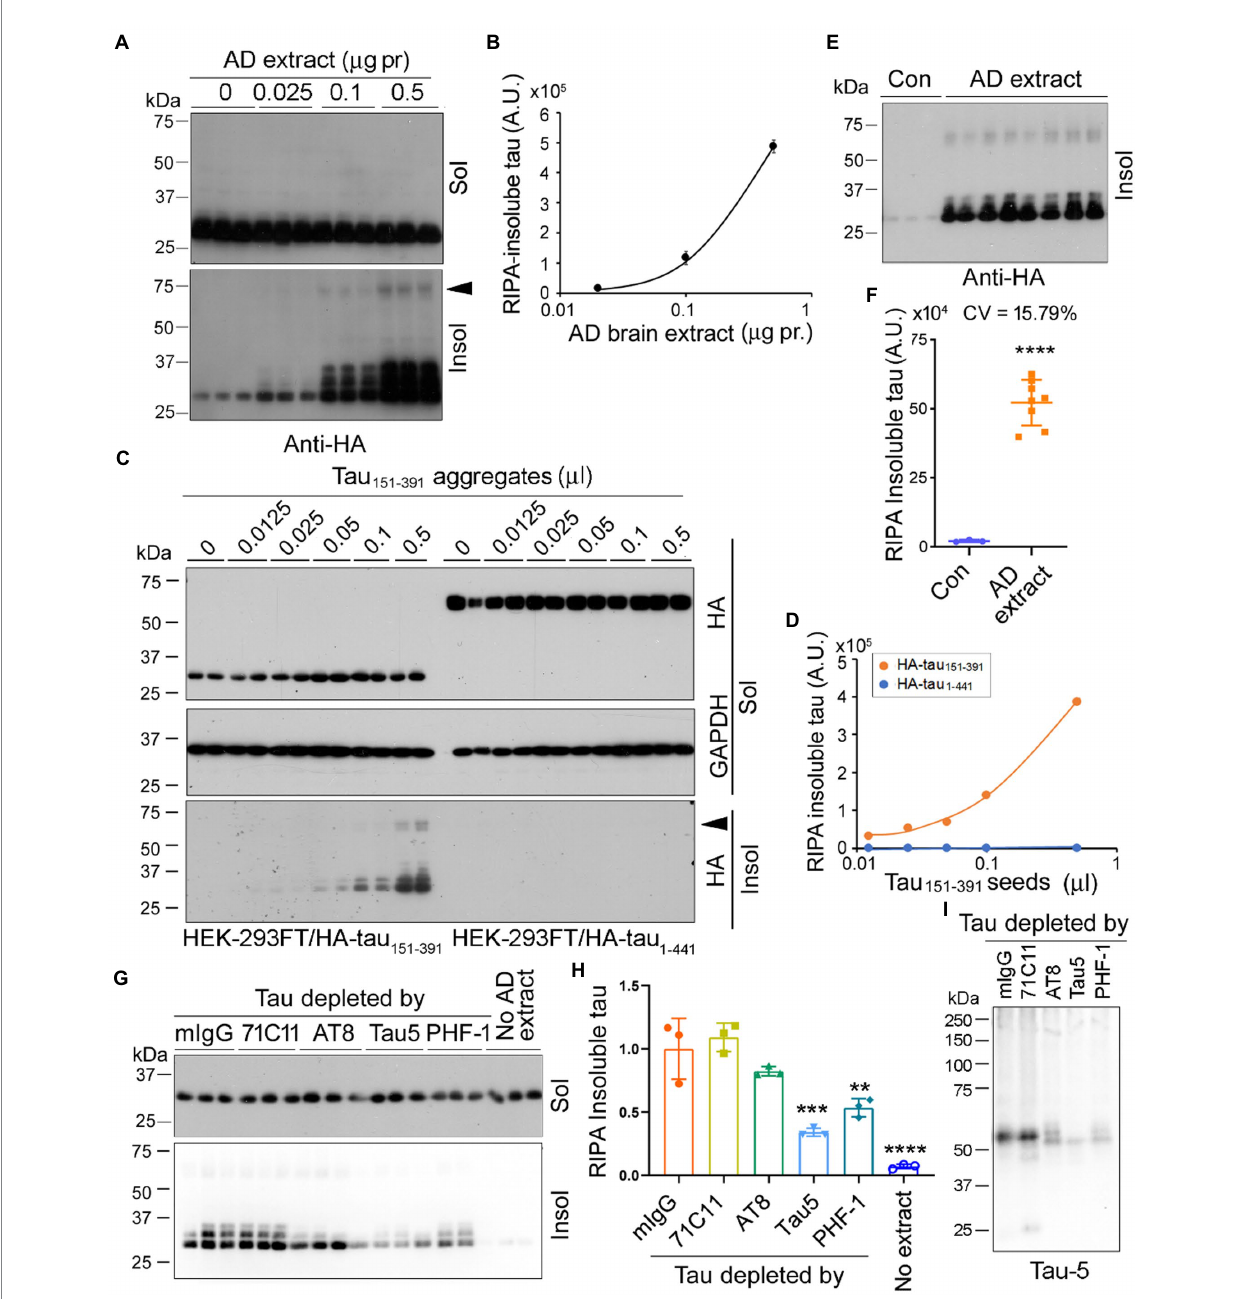
FIGURE 6 Seed-competent tau from AD brain templates tau 151-391 aggregation. (A,B) AD brain extract seeded tau aggregation. HEK-293FT cells expressing HA- tau 151-391 in triplicate were treated with various amounts of AD brain extract for 42 h. The RIPA-soluble and -insoluble taus were analyzed (A) . RIPA- insoluble tau was plotted against the amount of AD brain extracts (B) . (C,D) RIPA-insoluble tau aggregates seeded tau aggregation. HEK-293FT cells expressing HA-tau 151-391 or HA-tau 1-441 in duplicate were treated with various amounts of tau 151-391 aggregates for 42 h. The RIPA-soluble and -insoluble taus were analyzed (C) . RIPA-insoluble tau was plotted against amounts of tau 151-391 aggregates (D) . (E,F) AD brain extract seeded tau aggregation reproducibly. HEK-293FT/HA-tau 151-391 cells were treated with 0.5 μ g protein of AD brain extract in octuplicate. The RIPA-insoluble tau was analyzed, and the coefficient of variation (CV) was calculated. (G–I) Depletion of tau from AD brain extract by tau antibody reduced the seeding activity. AD brain extract was incubated with mouse IgG (mIgG) or tau antibodies, 71C11, AT8, Tau5, and PHF-1, pre-coupled onto-protein G beads overnight to deplete tau. HEK-293FT cells expressing HA-tau 151-391 in triplicate were treated with 0.5 μ g protein of brain extract for 42 h. The RIPA-soluble and -insoluble taus were analyzed (G) . Relative levels of RIPA-insoluble tau are presented as mean ± SD (H) . The brain extracts were subjected to Western blots developed with Tau5 (I) . Arrowhead indicates the SDS- and β -ME-resistant HMW-tau species. ** p < 0.05; *** p < 0.001; **** p < 0.0001; * vs mIgG; # vs no